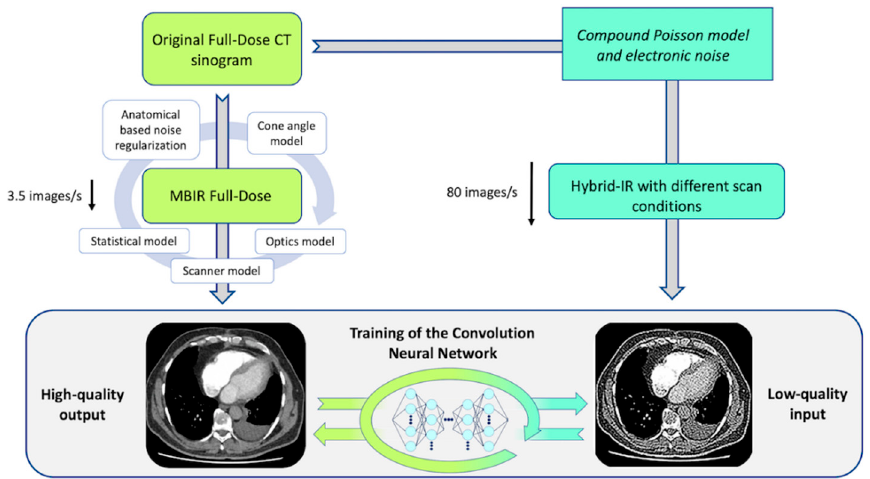
Figure 1. Schematic representation of the DLR training process. DLR, deep learning reconstruction; CT, computed tomography; IR, iterative reconstruction; MBIR, model-based iterative reconstruction.